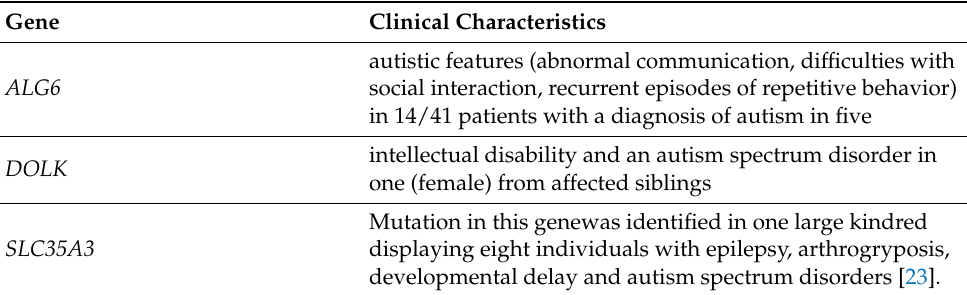
Table 5. Autistic spectrum disorder as a feature of CDG [5,14,20,23,76]. Gene Clinical